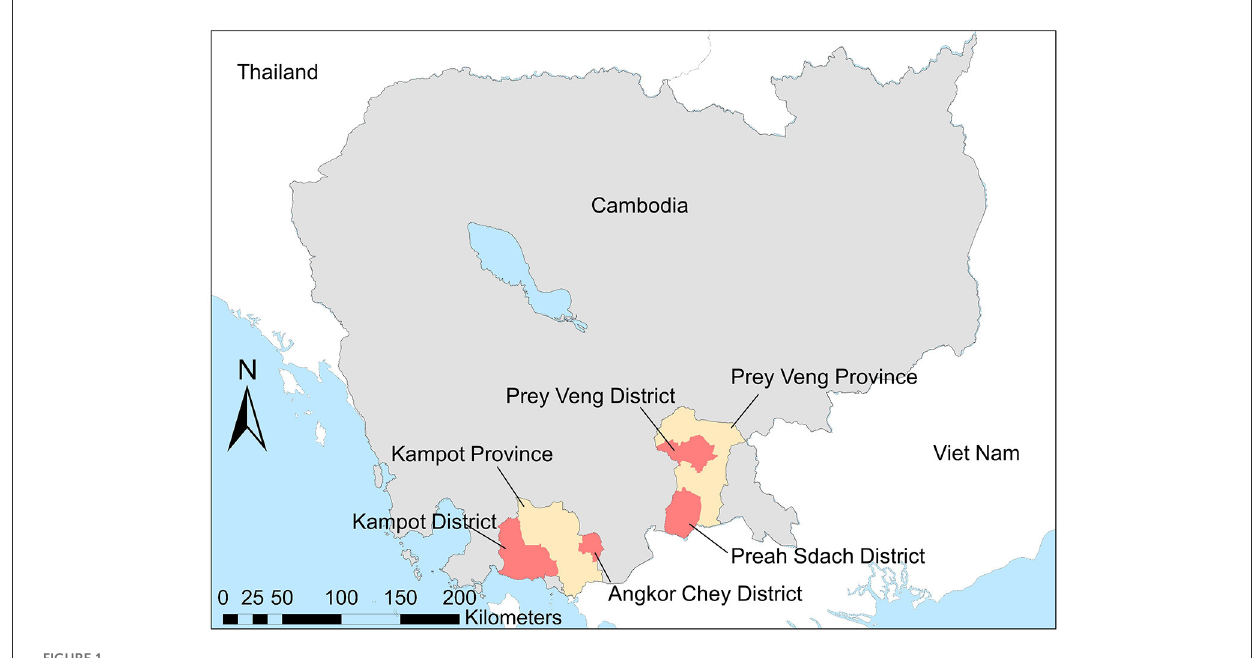
FIGURE1 Map of the study